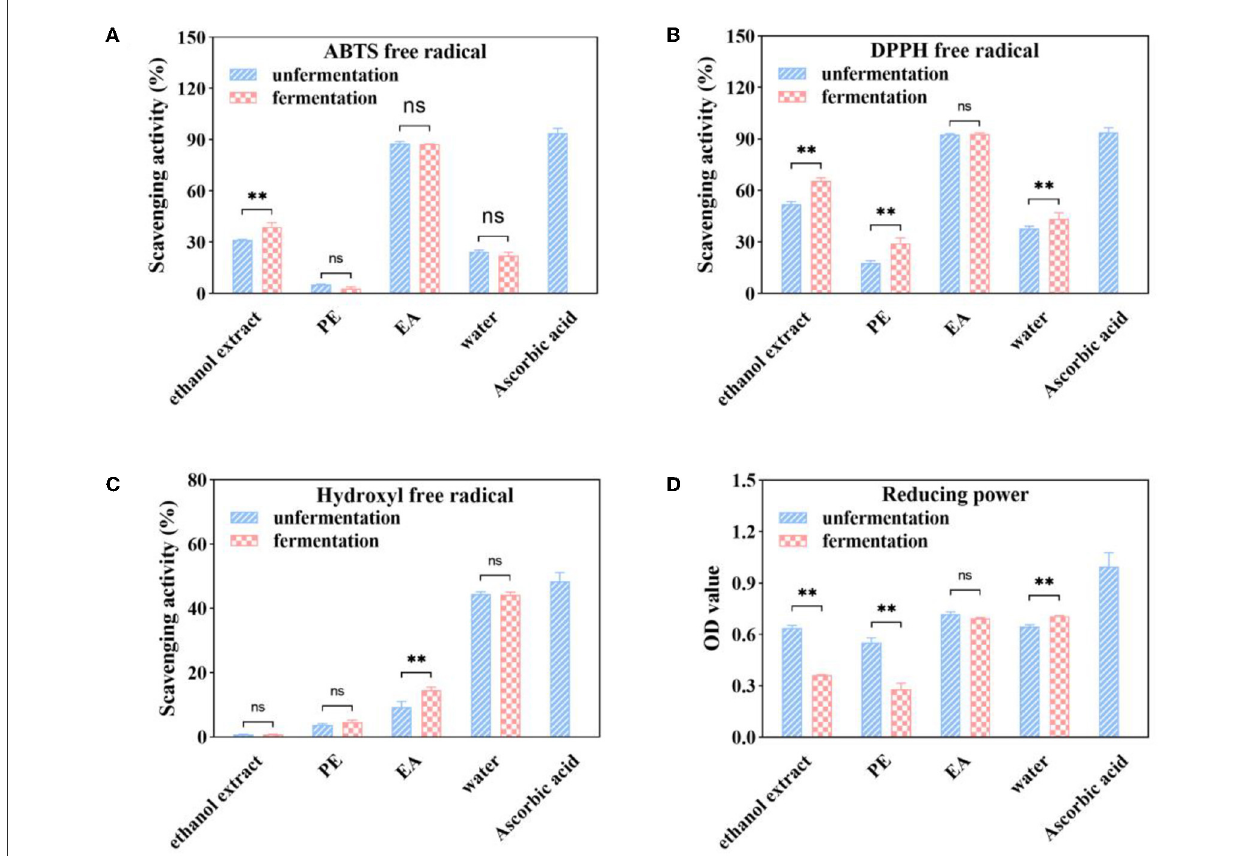
FIGURE3 ABTS · + (A) , DPPH (B) , hydroxyl (C) , and free radical scavenging activities and reducing power (D) of soluble phenolic extracts at different subfractions from AVL fermented with A. niger (100 µ g/ml of ascorbic acid as a positive control). ** P <